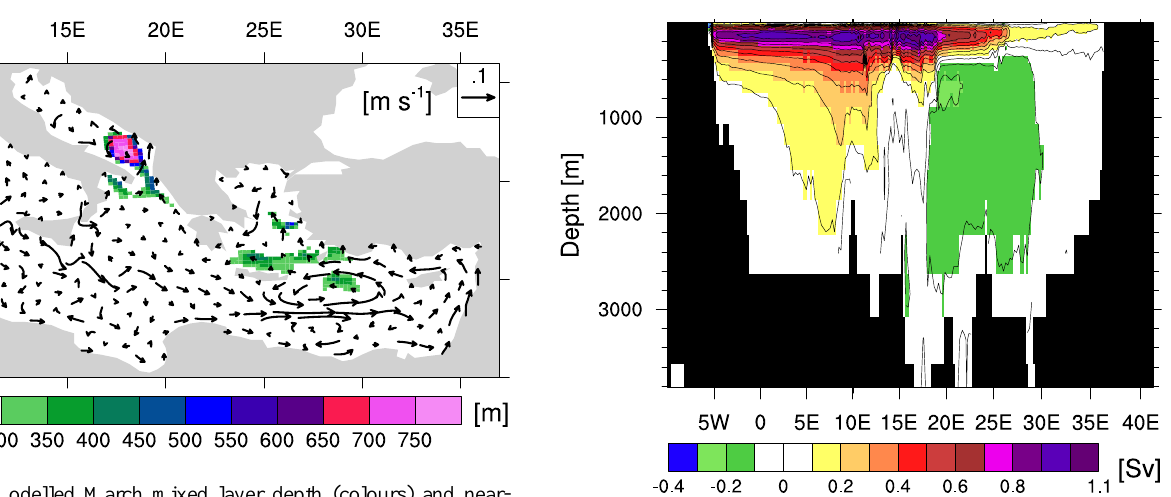
Fig. 3. Modelled March mixed layer depth (colours) and near- surface currents field (arrows) at 27m depth for CTRL. Only a sub- set of vectors has been plotted. The mixed layer depth is reached when the density difference between this depth and the surface ex- ceeds 0.125kgm − 3 . Note that such a calculation can only give an approximative estimate of the depth of the mixed layer.